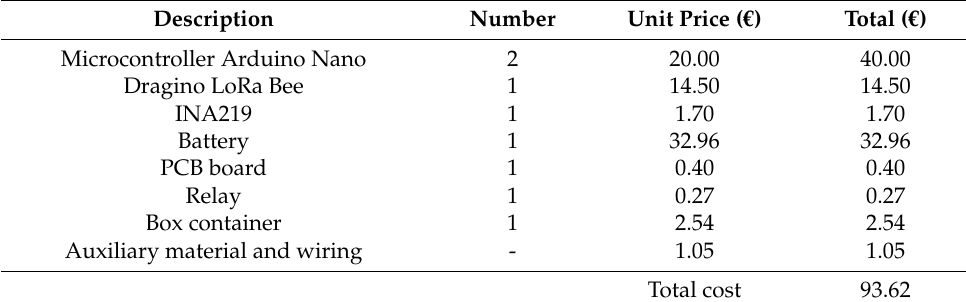
Table 9. Cost of components for the ECDL with a battery power supply.